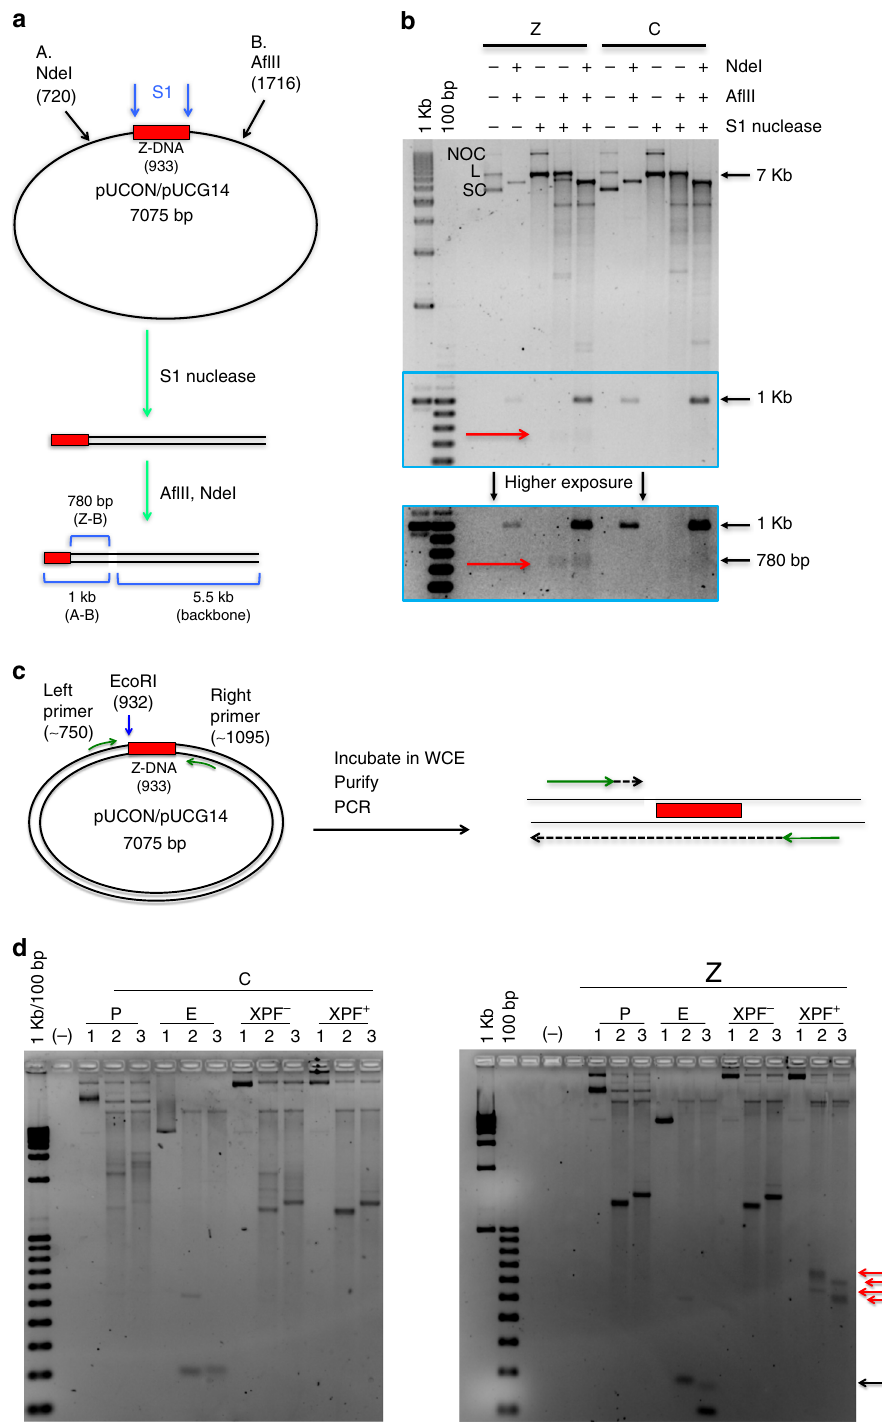
Fig. 3 ERCC1-XPF cleaves near the Z-DNA-forming region. a S1 nuclease assay schematic. b Top panel: SYBR Gold-stained agarose gel demonstrating S1 cleavage at single-stranded regions corresponding to the B-Z junctions on the Z-DNA-forming plasmid (Z), resulting in ~780 bp fragment (red arrow) that is absent in the control B-DNA plasmid (C). Bottom panel: higher exposure of S1 cleavage product. [NOC, nicked open circular; L, linear; SC, supercoiled species]. c PCR primer extension assay schematic using plasmid DNA in human XPF-pro fi cient or XPF-de fi cient WCE. Puri fi ed DNA was used as a template for a primer extension assay using either the left or right primer (green arrows). d PCR products were separated on a 1.5% agarose gel revealing extra cleavage products (red arrows) from the Z-DNA plasmid in XPF-pro fi cient WCE. Plasmid DNA only (P) served as a negative control, and EcoRI (E), restriction at the Z-DNA-forming insert served as a positive control, resulting in ~160 or ~180 bp products (black arrow). Lane 1: template only; lane 2: left primer; and lane 3: right primer. See also Supplementary Table 1. Extension products of >1000 bp resulted from primer “ run off ” from the template. Shorter extension products resulting from cleavage on plasmids in WCE are indicated by red